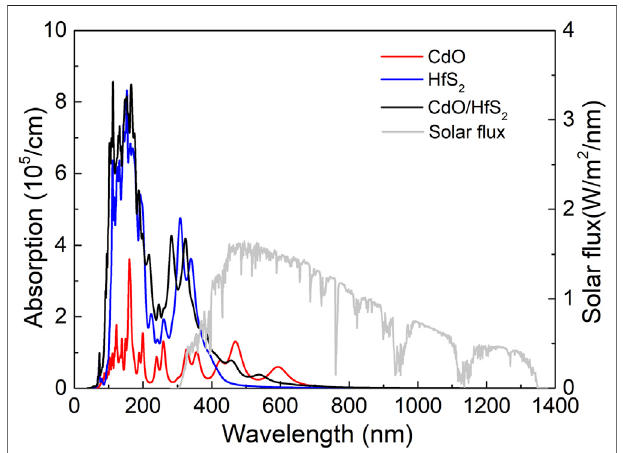
FIGURE 5 | The optical absorption spectrum of the monolayered CdO, HfS 2 , and CdO/HfS 2 vdW heterostructure calculated by the HSE06